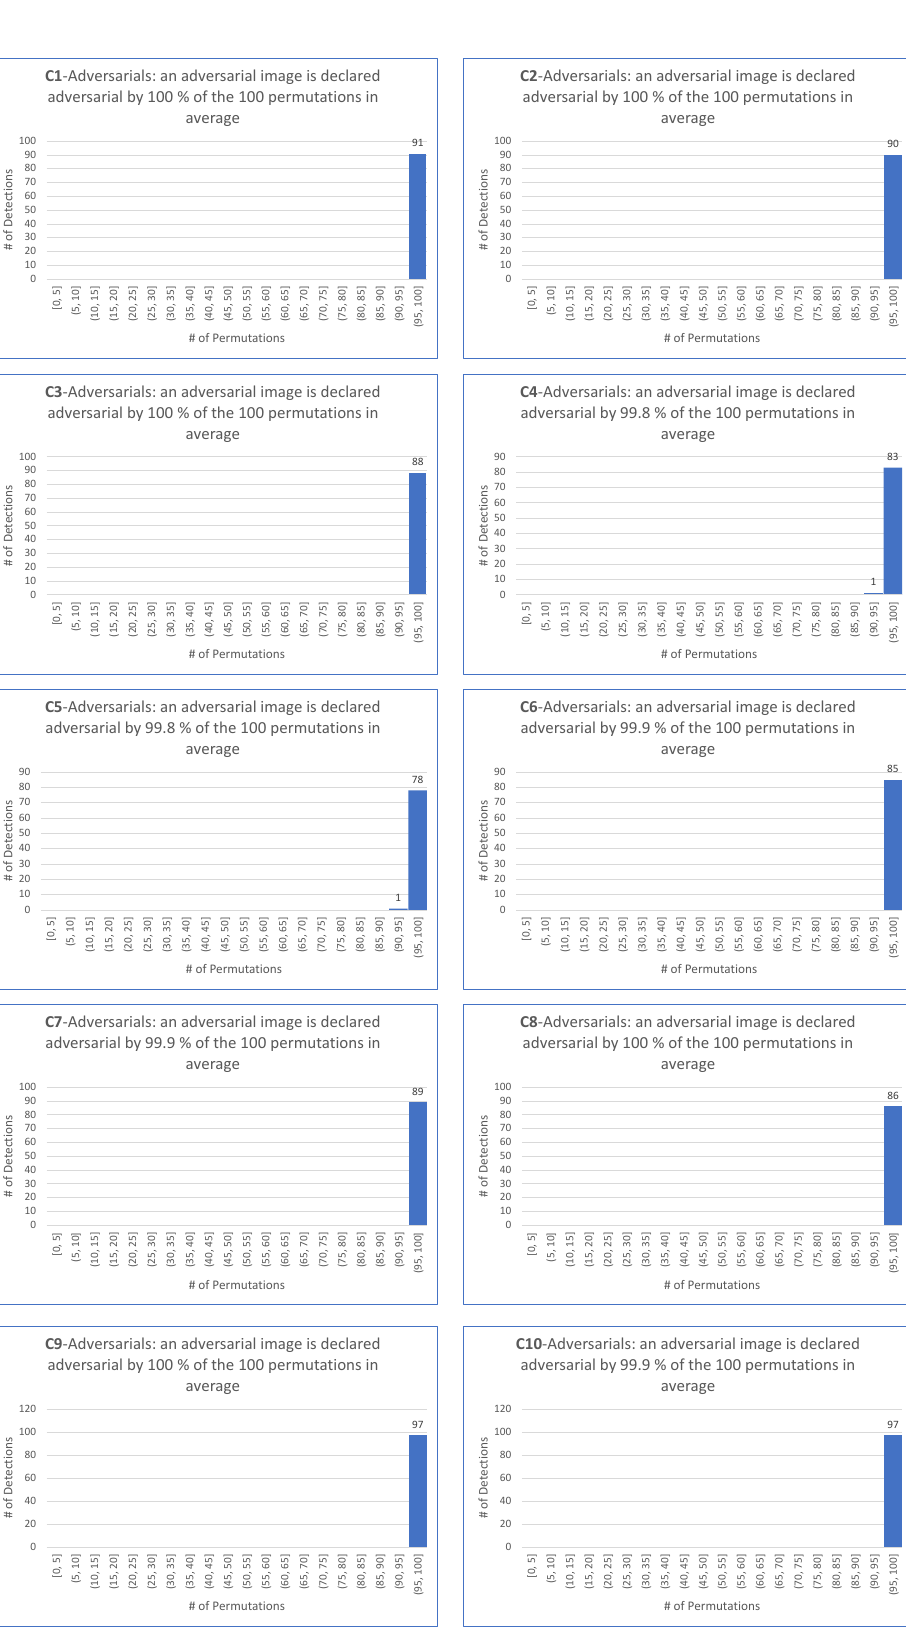
Figure A3. ShuffleDetect results for adversarial images generated by the EA-targeted attack on C = C for 1 ≤ k ≤ 10 over 100